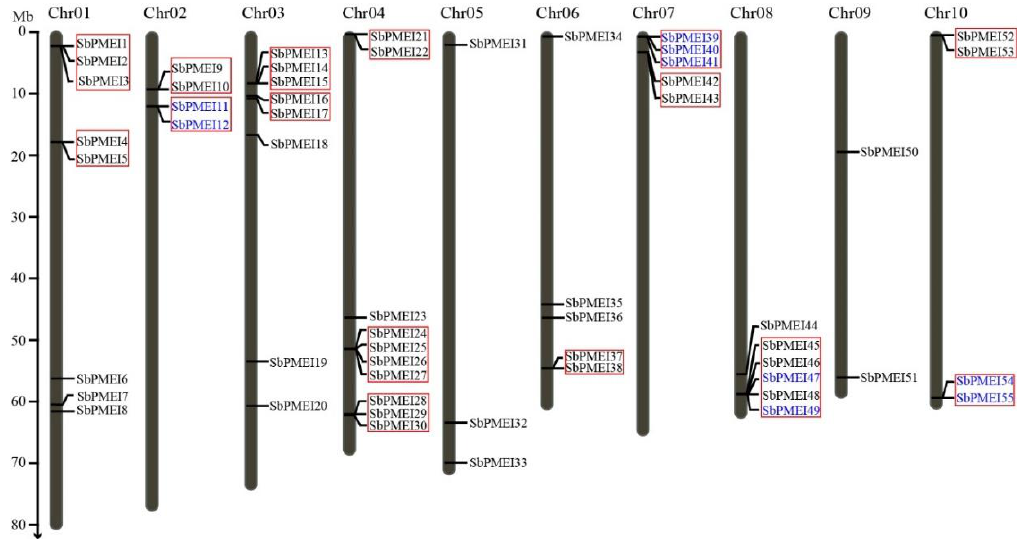
Figure 2. PMEI genes’ distribution on sorghum chromosomes. Red rectangles represent the gene clusters, with the distance of SbPMEIs in a 100 kb region within an individual chromosome. The tandem gene duplications are indicated by blue colored names. Chr: Chromosome. gene duplications are indicated by blue colored names. Chr: